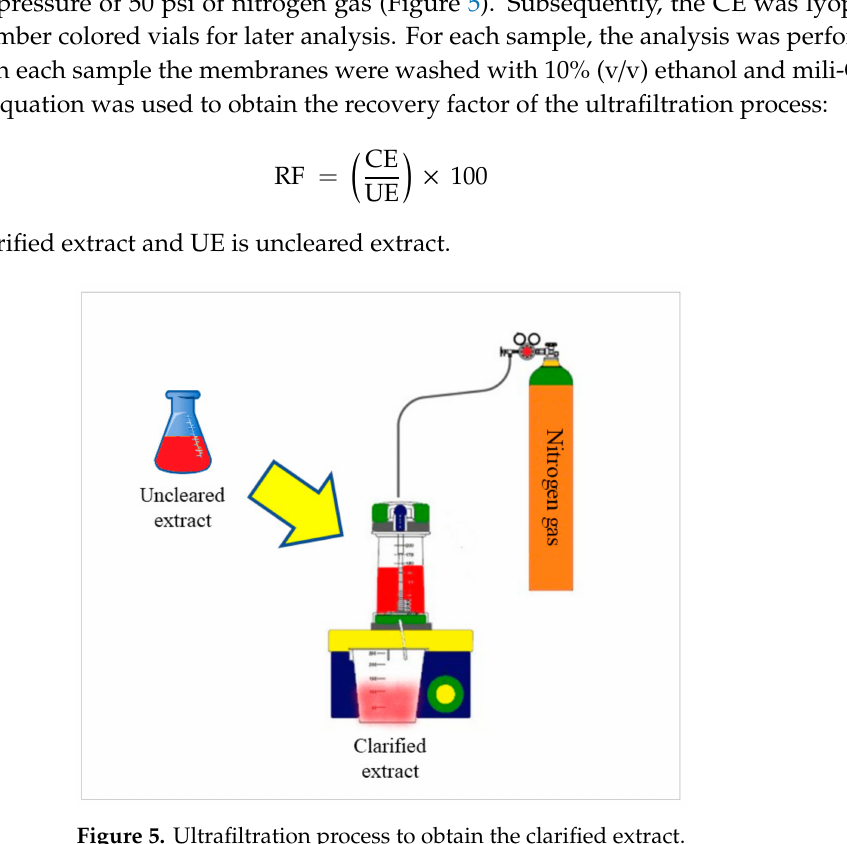
Figure 5. Ultrafiltration process to obtain the clarified